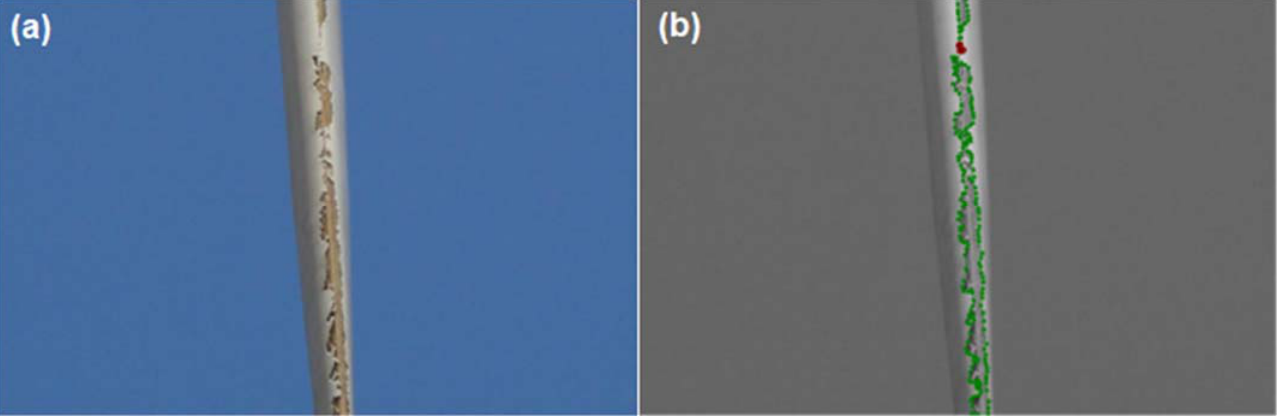
Figure 6. Example image ( a ) and CNN annotations ( b ) used to train the supervised learning damage detection model. Coherence areas with shallow damage are outlined in red, while coherent areas with deep damage are outlined in green.